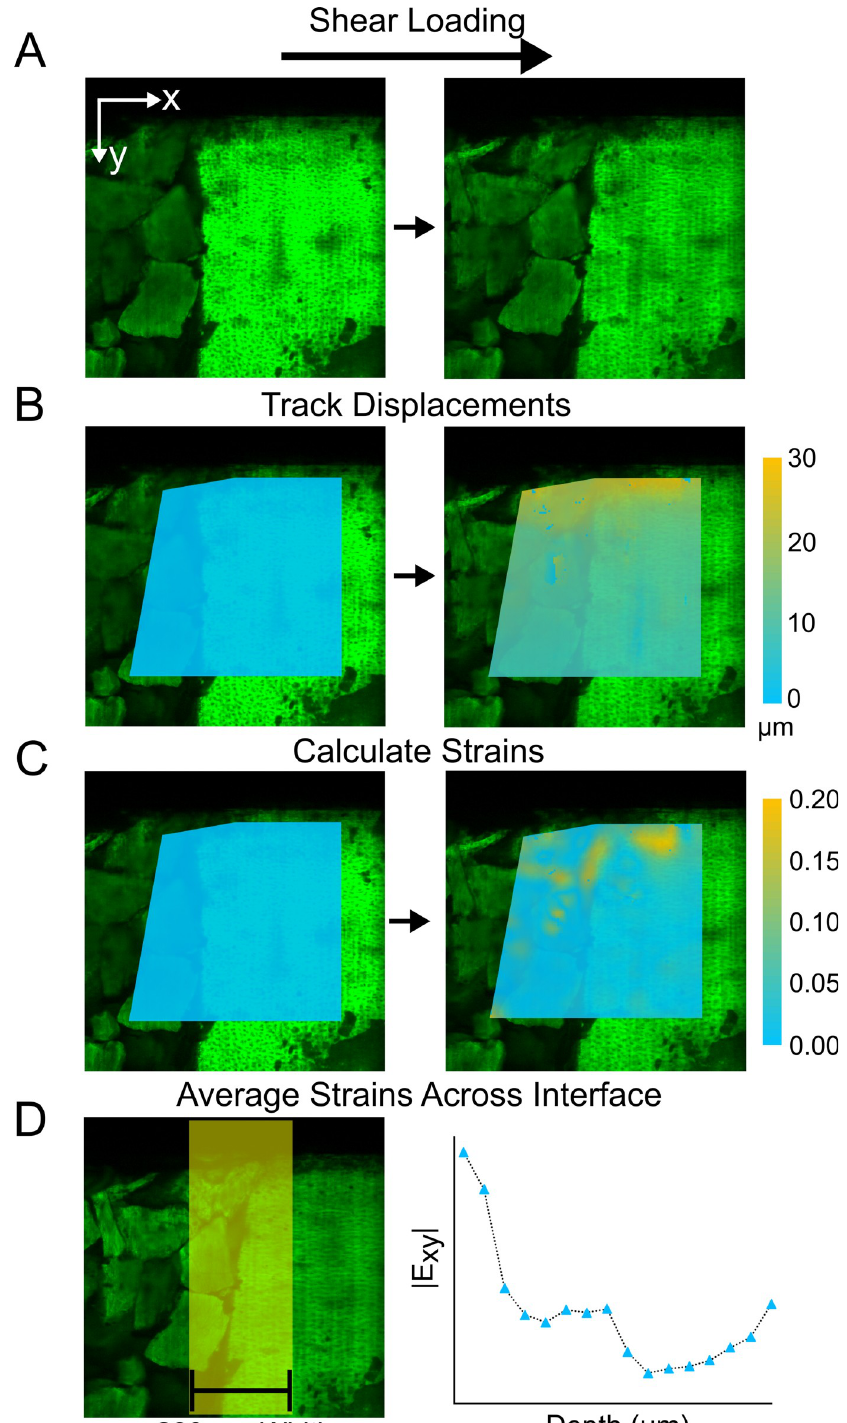
Fig 2. Repair interface strain analysis. Fluorescent confocal images with sealant and BioCartilage repair on the left of the interface and healthy tissue on the right. Under shear loading, the repair and healthy tissue are displaced but remain intact (A). Displacements were tracked using Ncorr in Matlab in drawn region of interest (B). Heat maps of displacements are plotted on the fluorescent images showing highest displacements in the x direction at the surface of the construct for both the repair and healthy tissue. Strains were calculated from displacements (C). Strain magnitudes were averaged across a 200 μ m width interface region in the x direction and plotted as a function of depth (D). https://doi.org/10.1371/journal.pone.0224756.g002 PLOS ONE | https://doi.org/10.1371/journal.pone.0224756 November8, 2019 6 /